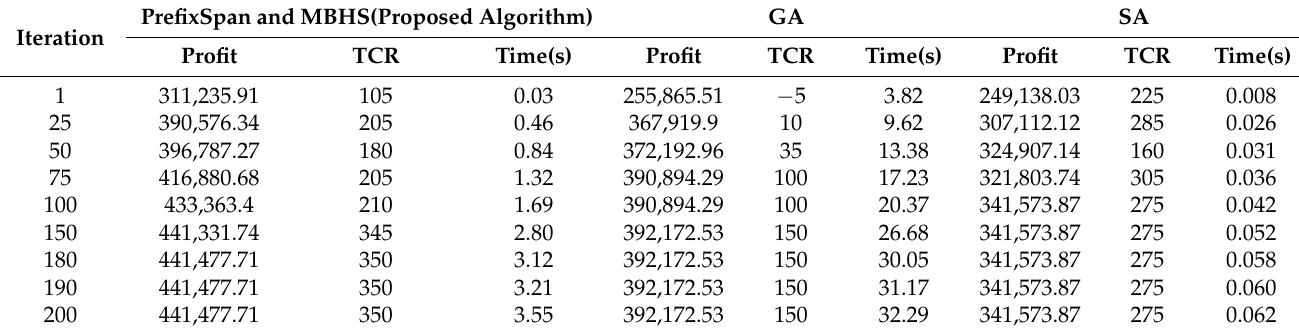
Table 12. Comparison of the profit volume and total closeness